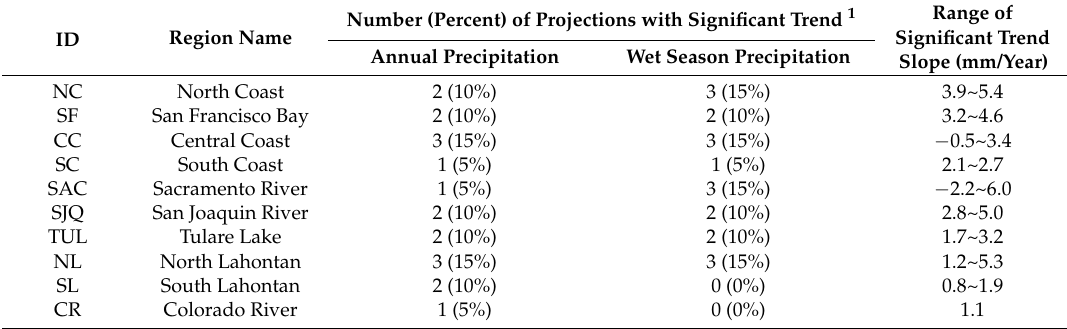
Table 5. Trend information of projected